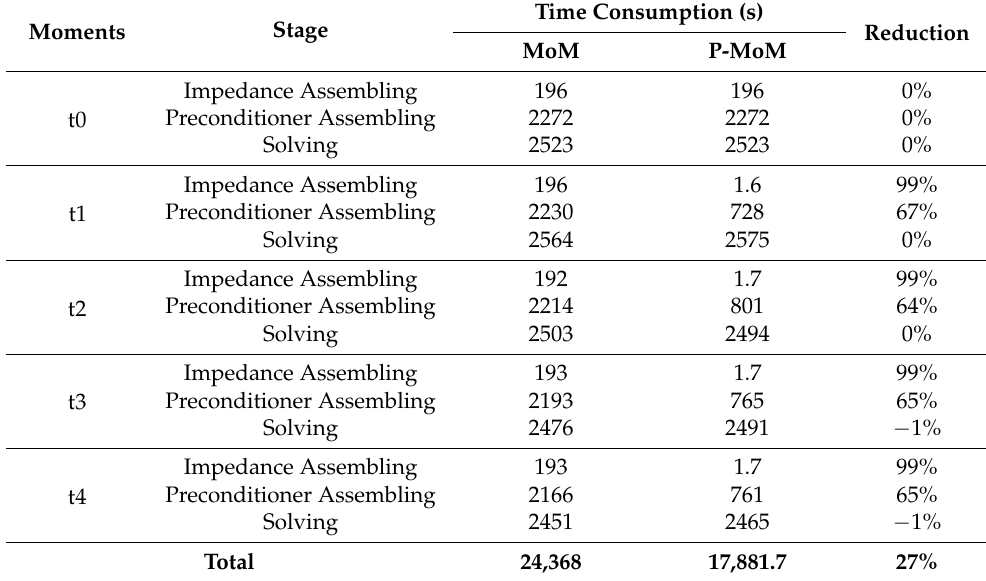
Table 1. The time consumption at different stages of the five moments using MoM and